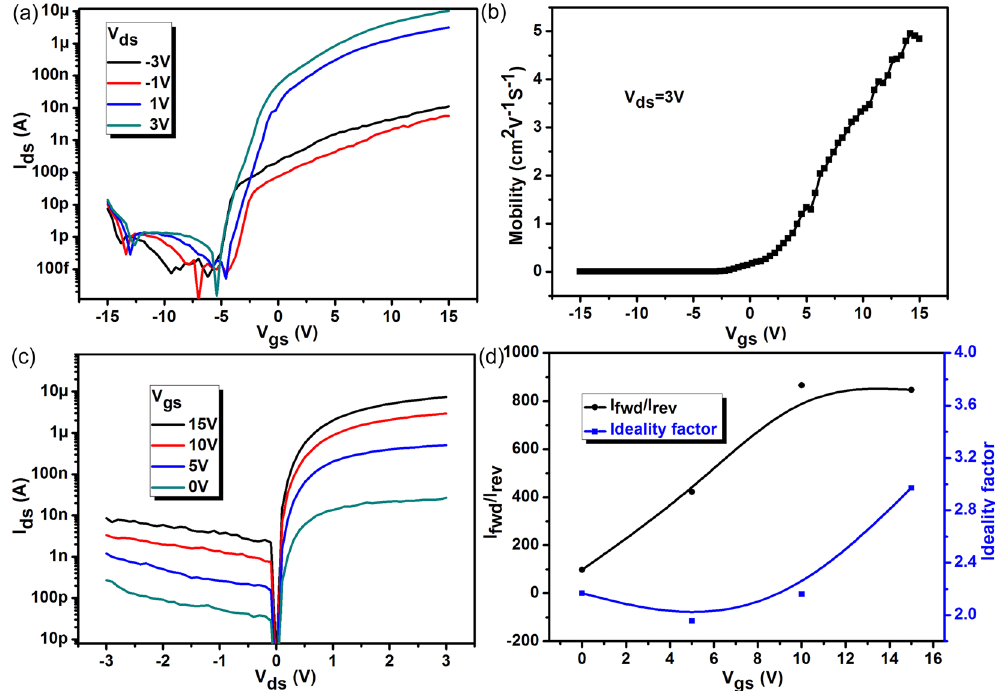
Figure 2. ( a ) Transfer curves of the multilayer/monolayer MoS 2 heterojunction for both forward and reverse V ds bias with back gate modulations. ( b ) Variation of field effect mobility with gate voltage V gs obtained from the analysis of experimental transfer characteristics at V ds = 3 V. ( c ) Gate tunable I ds − V ds characteristics of the heterojunction. ( d ) The rectification ratio I fwd / I rev and the ideal factor of the heterojunction as a function of back gate voltage V gs